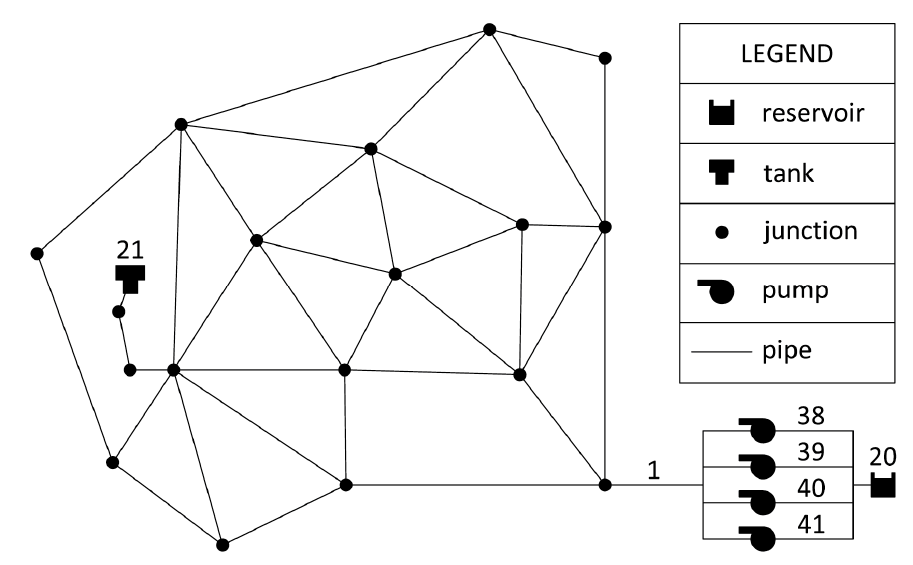
Figure 1. Anytown water distribution network model [39].